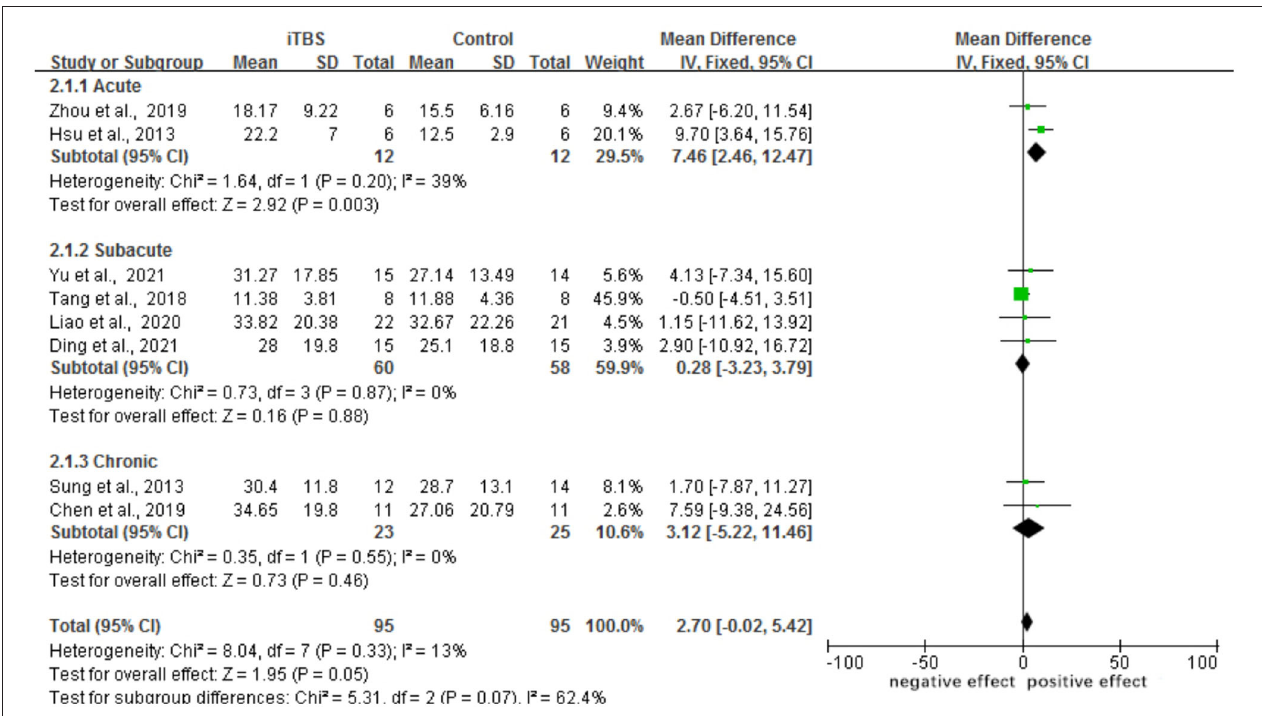
FIGURE 4 | Forest plots of the pooled results on motor function.